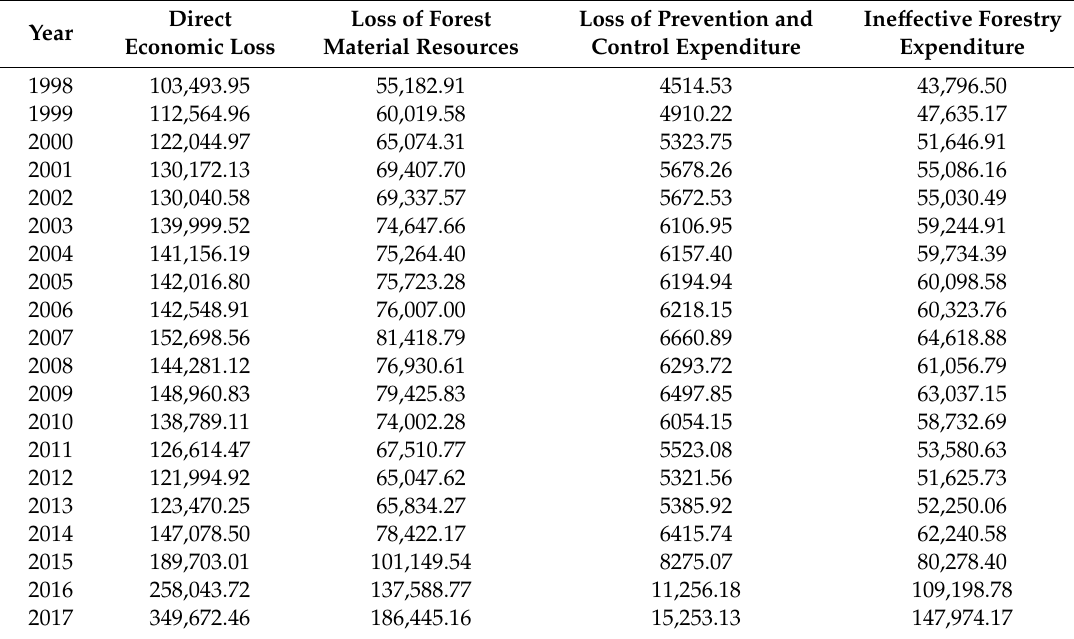
Table A4. Direct economic losses from disease in Mainland China from 1998 to 2017 (Secondary indicators) / 10 4 CNY.